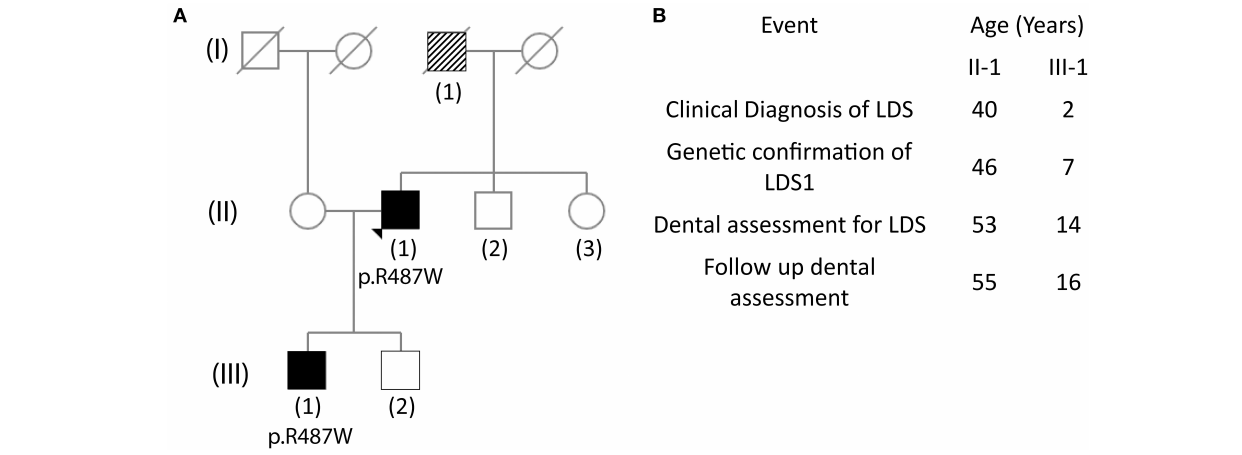
FIGURE 1 | Pedigree tree showing affected family members and timeline of events. (A) The (II-1) father of the proband is suspected of having Loeys-Dietz syndrome (LDS) as he died from an aneurysm at age 49. The mother of the proband has early-onset dementia. The brother of the proband is healthy, and the sister has skin carcinoma. Proband has two sons, one of whom (III-1) carries the LDS mutation. (B) Timeline of events for the proband (II-1) and the son of the proband (III-1) since diagnosis of LDS.